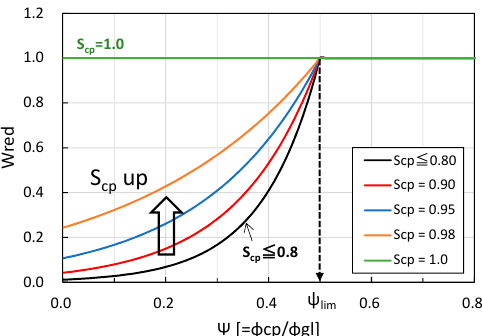
Figure 22. Relationship between the porosity ratio of capillary to gel, Ψ and the reduction factor against the amount of free water, w red.